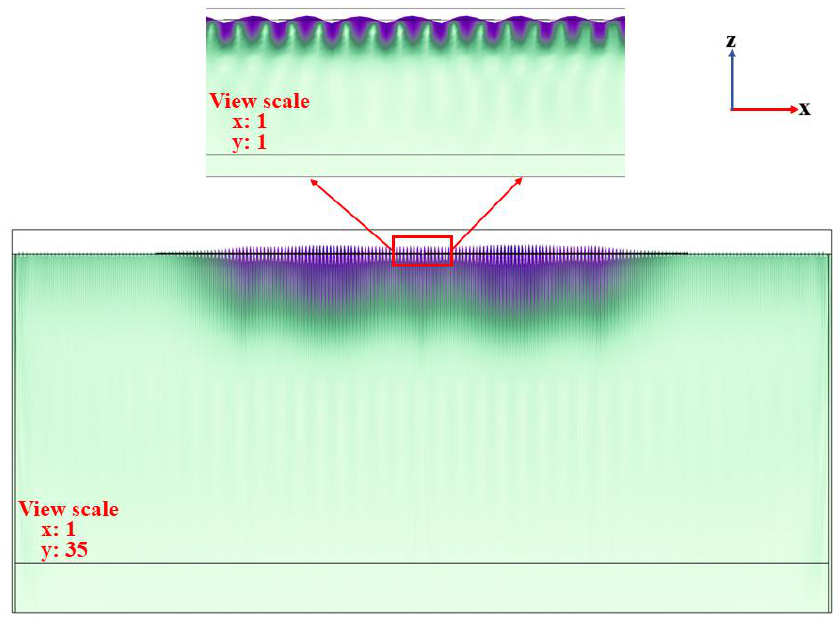
Figure 6. Distribution of the cloud map of the total displacement field of RSAW of the full-sized 2D model under initial structural parameters.